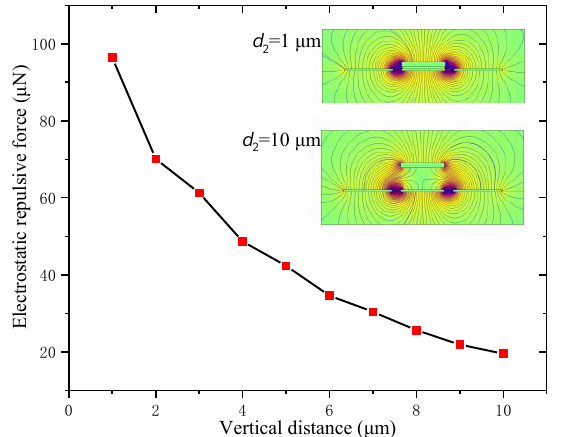
Figure 5. Electrostatic repulsive force versus the vertical distance between the moving electrode and the central fixed electrode ( V = 500 V, d 1 = 4 μm, W m = 20 μm, W f = 22 μm and h m = 2 μm) .